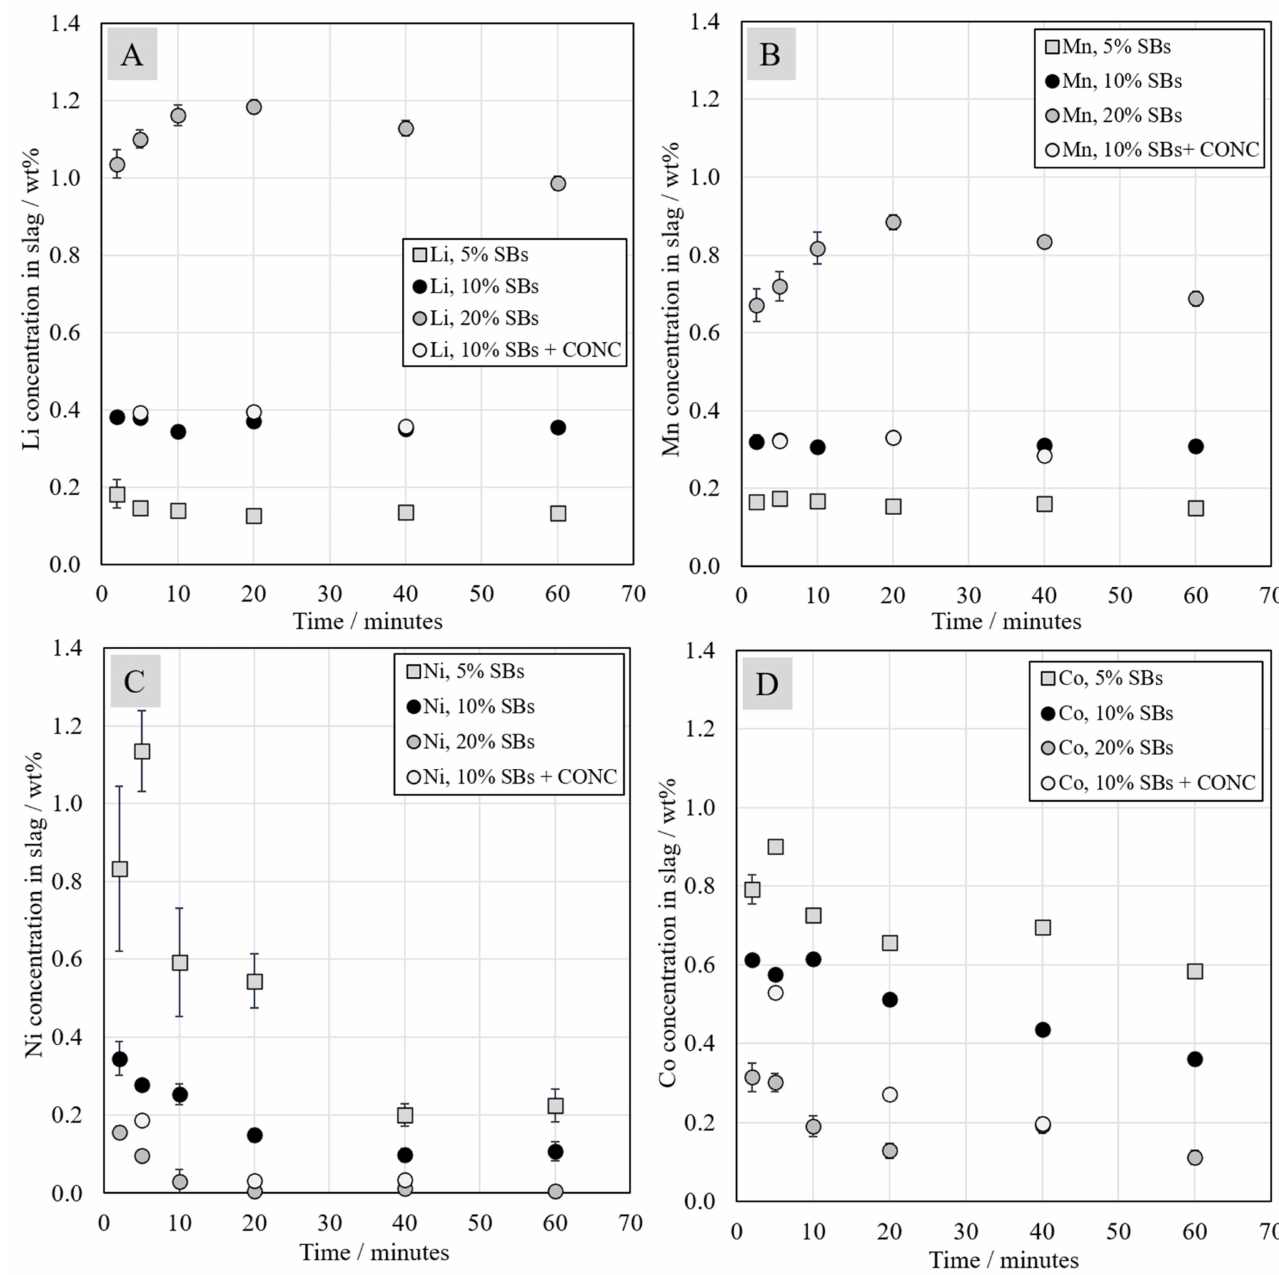
Figure 6. Chemical concentrations of Li ( A ), Mn ( B ), Ni ( C ), and Co ( D ) in the slags as a function of contact time at 1350 ◦